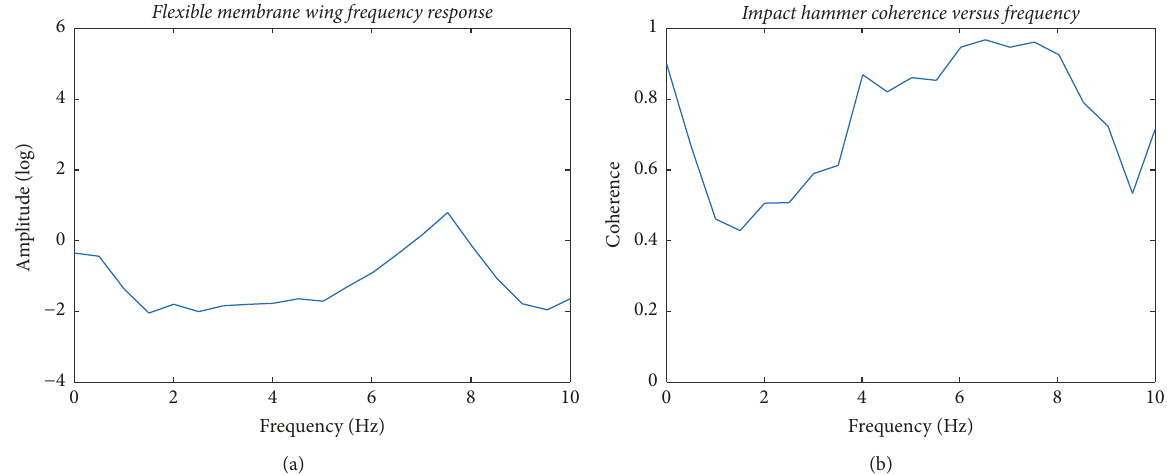
Figure 4: Results of the modal testing of the FMW: (a) frequency response of the FMW obtained from modal testing; (b) coherence of the frequency response.